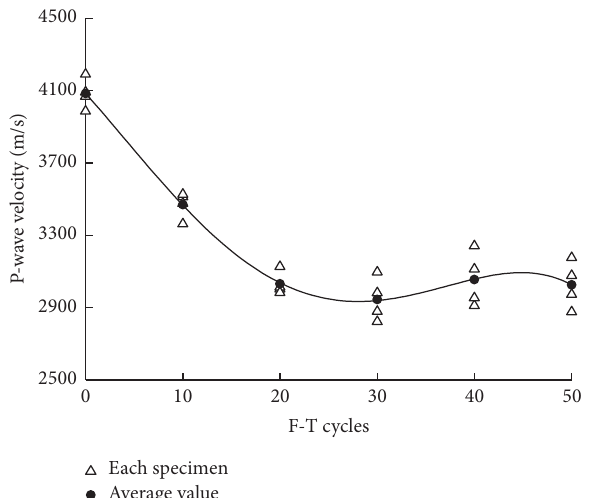
Figure 9: P-wave velocity variations after F-T cycling.